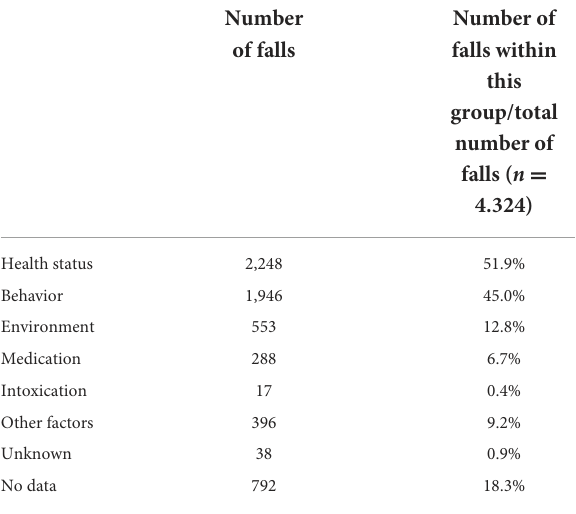
TABLE 2 Data on the frequencies of possible